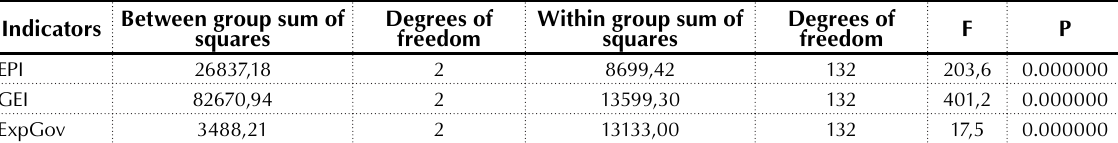
Table 4. Generalized results of one-factor dispersion analysis (dependent variable – successively each of indicators, predictor – cluster number)